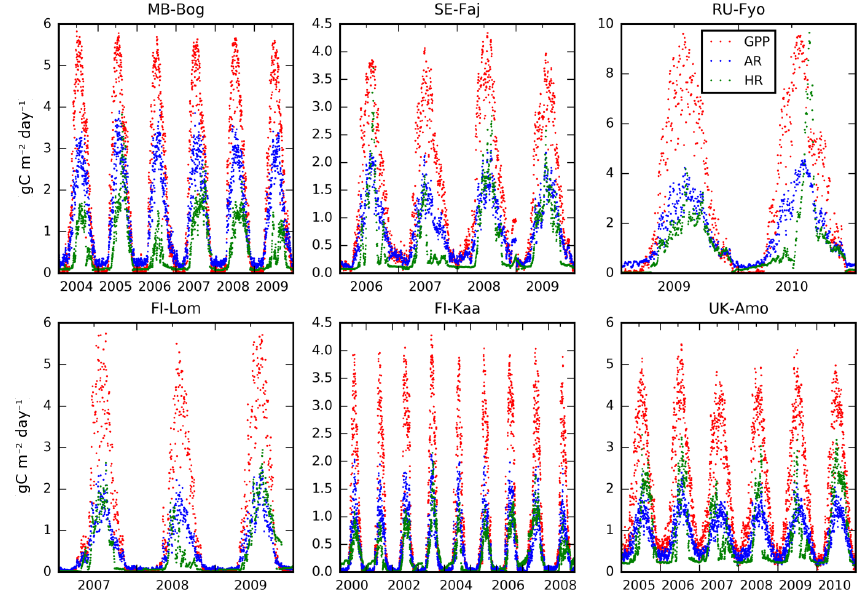
Figure 14. Simulated GPP, autotrophic respiration (AR) and heterotrophic respiration (HR) (gCm − 2 d − 1 ) for bogs and fens.